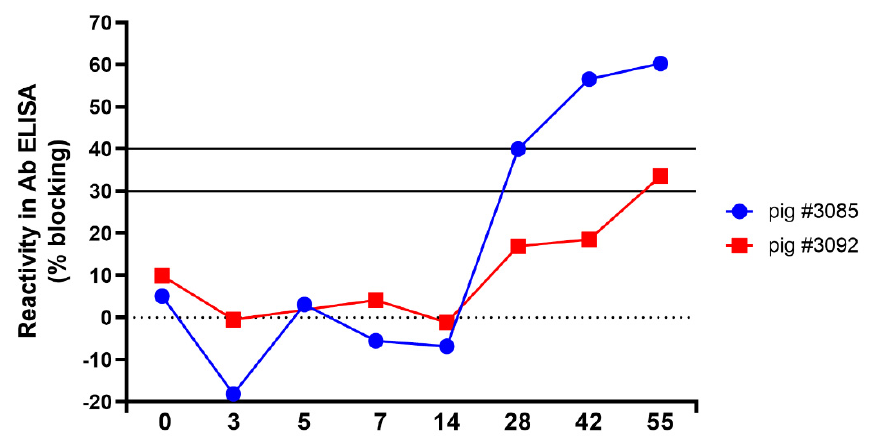
Figure 5. Detection of cross-reactive antibodies. Analysis of serum samples from two animals (#3085 and #3092) collected at the indicated time points after infection with Tunisian sheep-like virus isolate 70282/2007/EN using a commercial CSFV E2-specific antibody ELISA. Serum samples of the remaining two animals of the TSV infection group (animals: #3090 and #3096) tested positive in the NT using the CSFV strain Diepholz, but negative in the NT using CSFV strain Alfort/187 and in the CSFV-specific ELISA. Taken together, no clear differentiation between CSFV and TSV was possible for both samples with a doubtful or positive ELISA result.